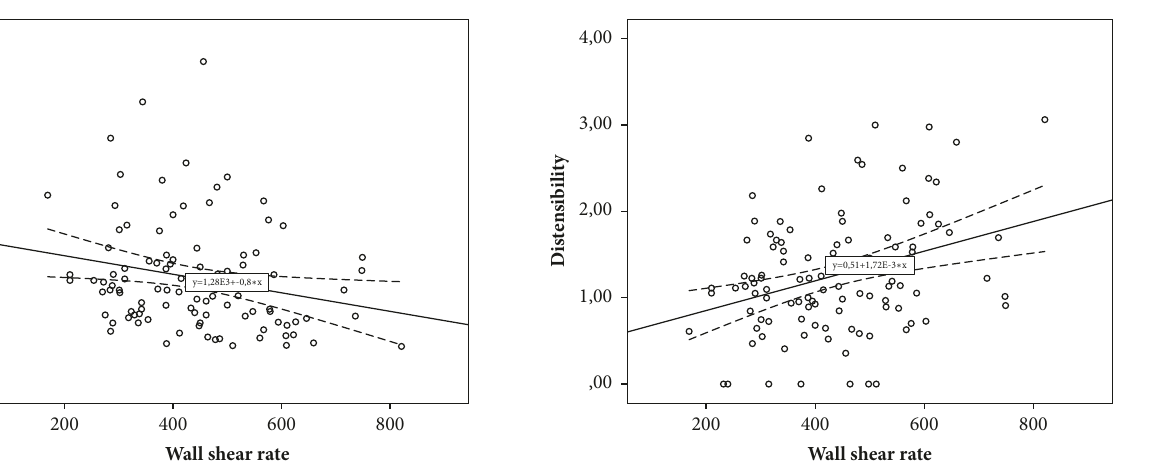
Figure 2: The relationship between wall shear rate and Peterson’s elastic modulus.